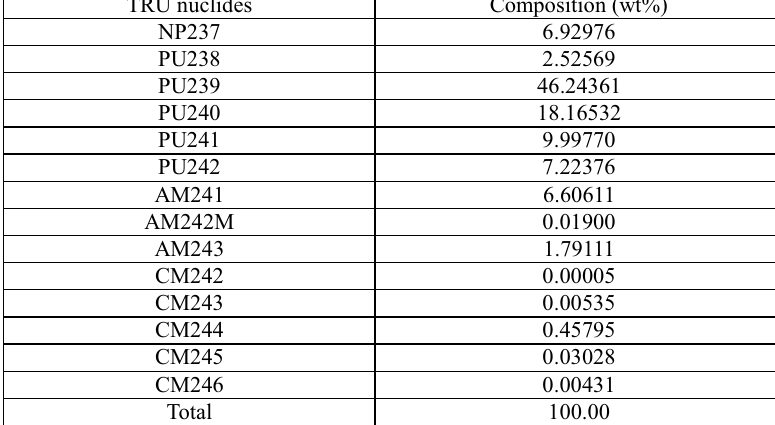
Table I. Initial TRU composition corresponding to burnup of 50 MWD/kg and cooling time of